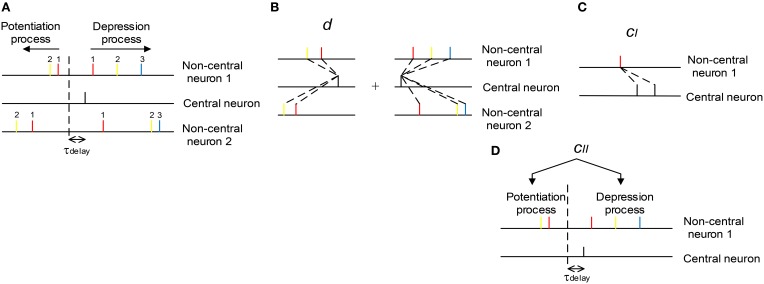
The scheme we use to understand the influence of synchronous firing and auto-correlation structure onto DiffV. (A) The indexing of j (see text). The non-central spikes of the same color have the same j index (indicated by the numbers). The dashed vertical line represents the separation of the potentiation and depression process caused by the black spike of the central neuron. Synapses between the central and non-central neurons have axonal delay τdelay. (B)
d represents the mean efficacy variability caused by a single central spike in the potentiation process plus that in the depression process. (C)
cI represents the efficacy variability contributed by the correlation between synaptic changes caused by adjacent central spikes. (D)
cII represents the efficacy variability contributed by the correlation between the total potentiation and depression value imposed on the same synapse.